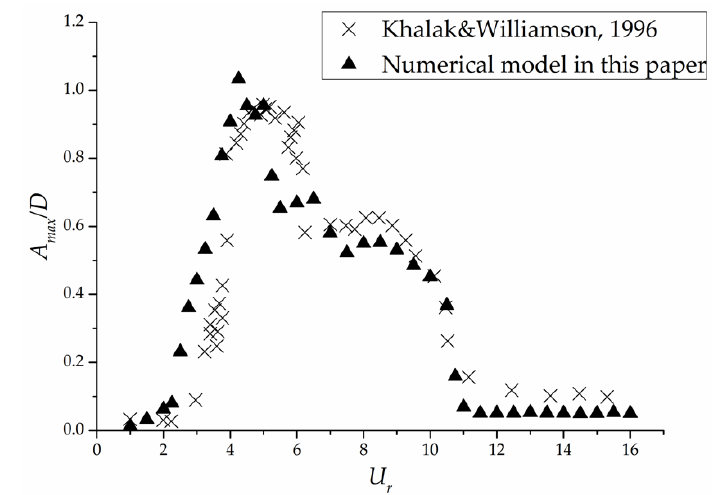
Figure 5. Calculation result comparisons of cylinder with spring and damping.